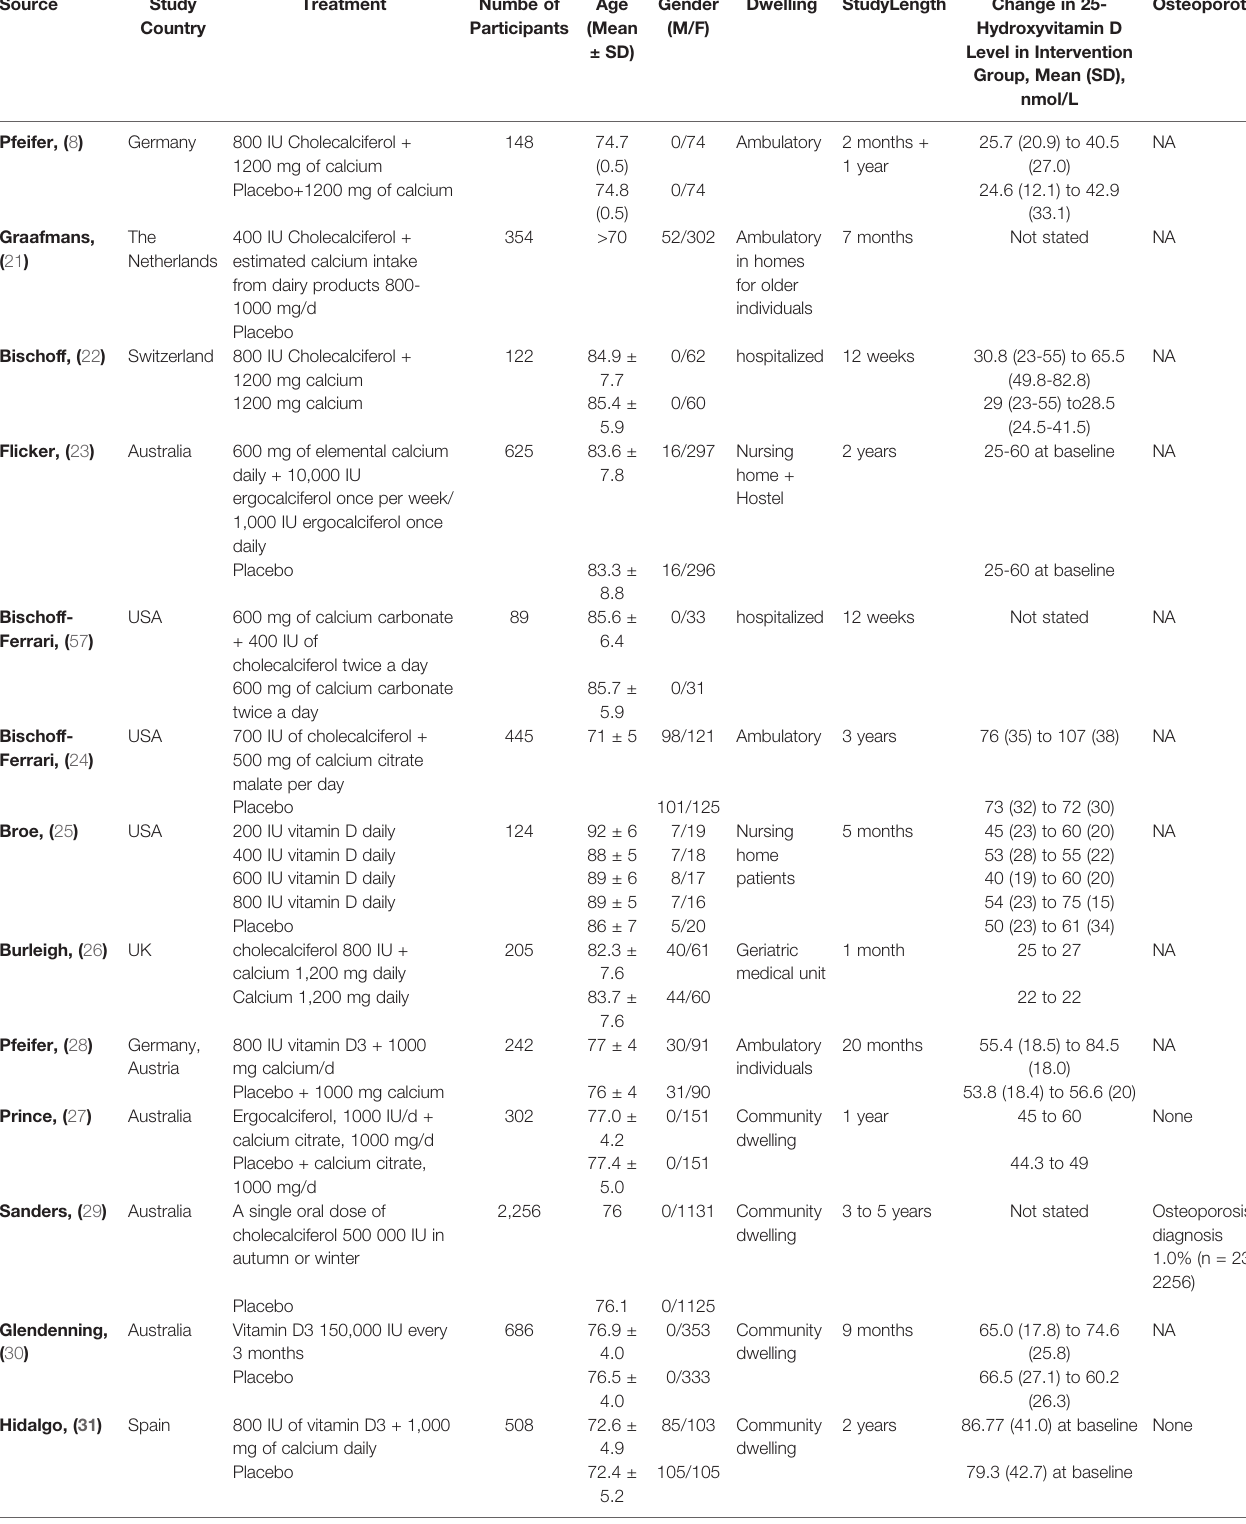
TABLE 1 | Characteristics of the included trials and